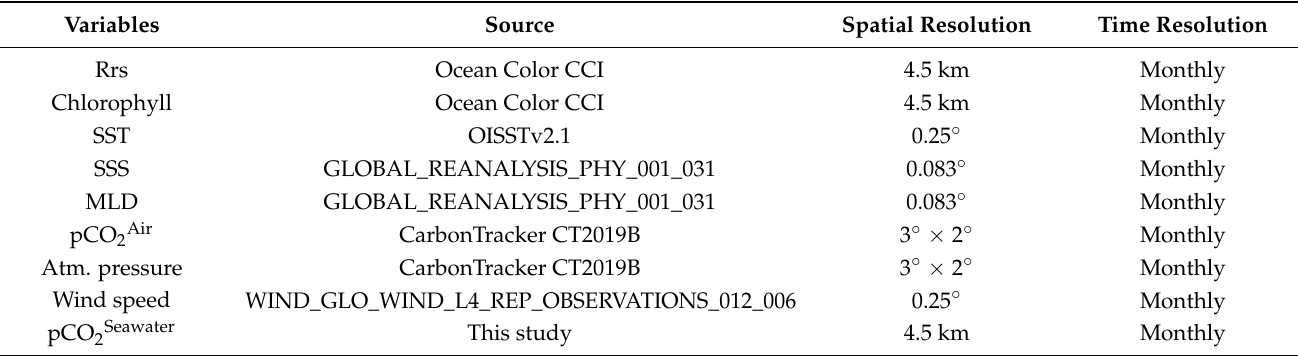
Table 1. Input variables for the sea-to-air CO 2